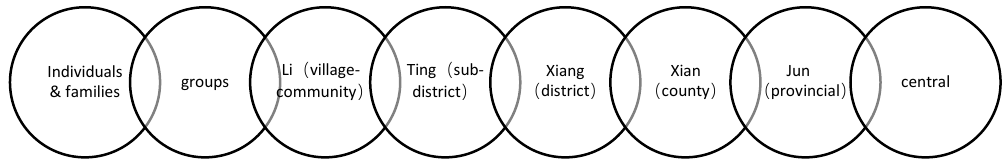
Fig. 5. The archetype of traditional Chinese Community Governance originated from the Qin Dynasty (developed by the